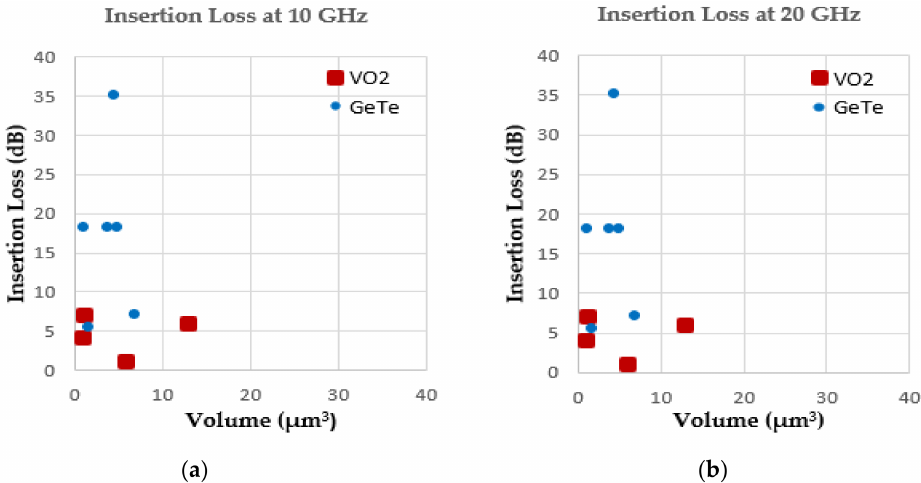
Figure 16. Insertion losses associated with each reported active volume of the device. ( a ) Insertion loss at 10 GHz; ( b ) Insertion loss at 20 GHz